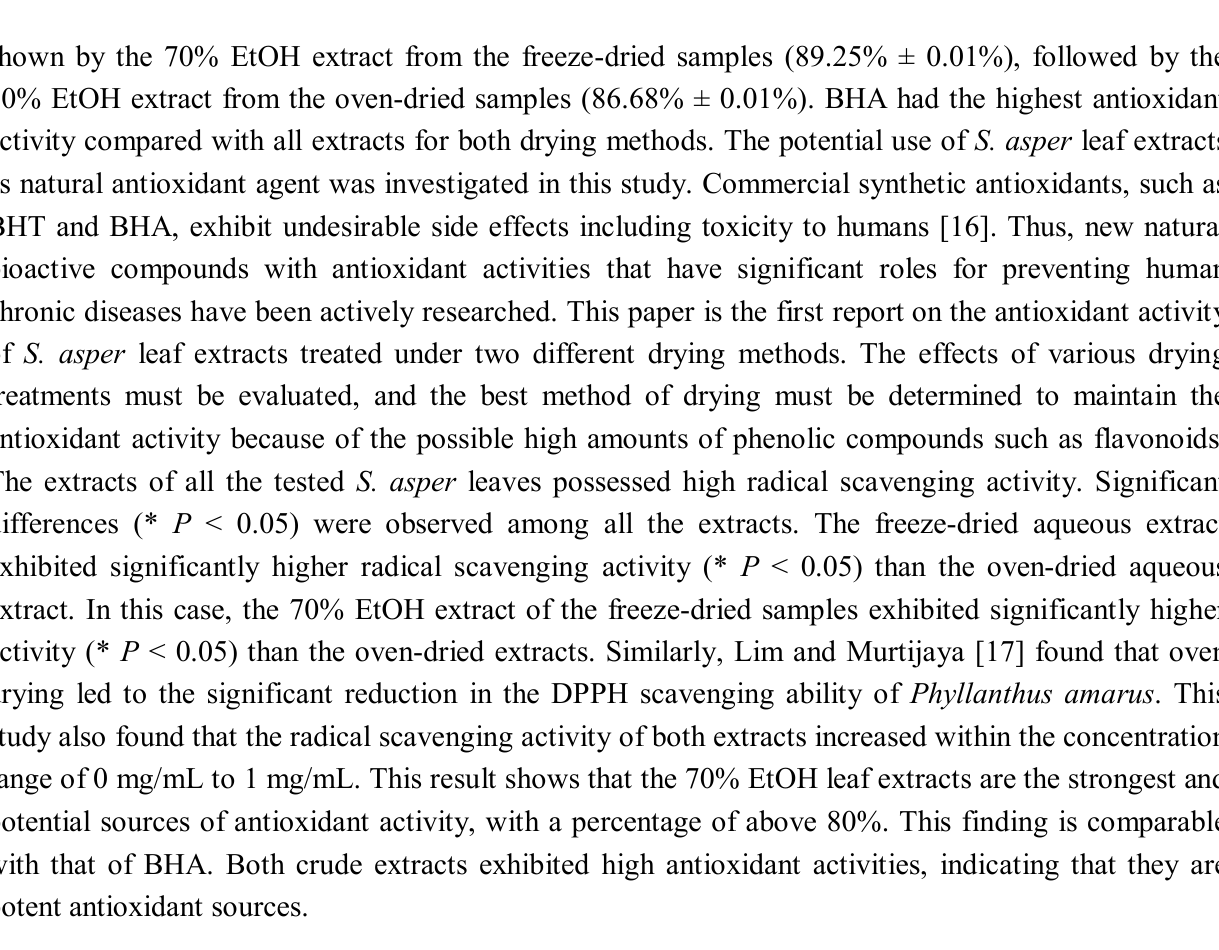
Figure 1. 1,1-Diphenyl-1-picrylhydrazyl (DPPH) free radical scavenging activity (%) of the aqueous and ethanol S. asper oven dried leaves extract and butylated hydroxyanisole (BHA). Mean ± standard deviation ( n =